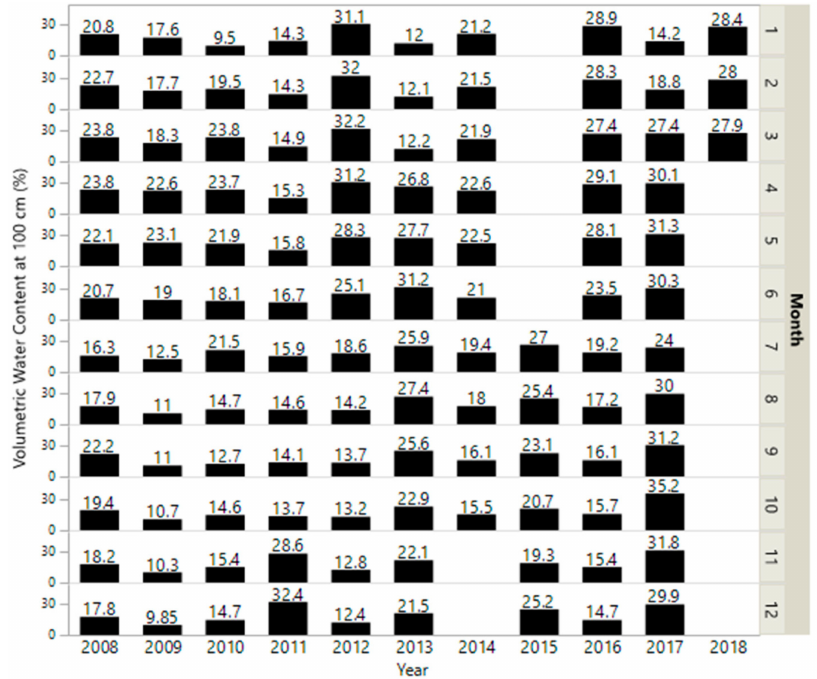
Figure A6. Monthly average volumetric water content (%) at 100 cm